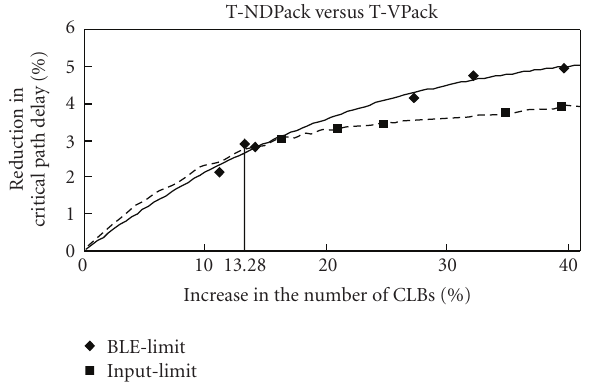
Figure 9: “ x -axis”: increase in the number of CLBs; “ y -axis”: reduction in critical path delay relative to T-VPack. Solid line represents: T-NDPack with ”BLE-limit” strategy. Dashed line represents: T-NDPack with “input-limit” strategy. As number of CLBs increase, critical path delay decreases for both